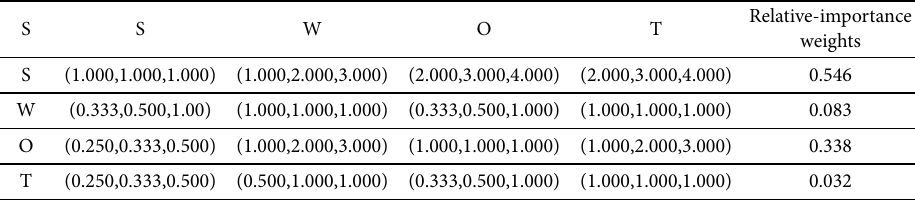
Table 4. The relative-importance weights for the “S” factor